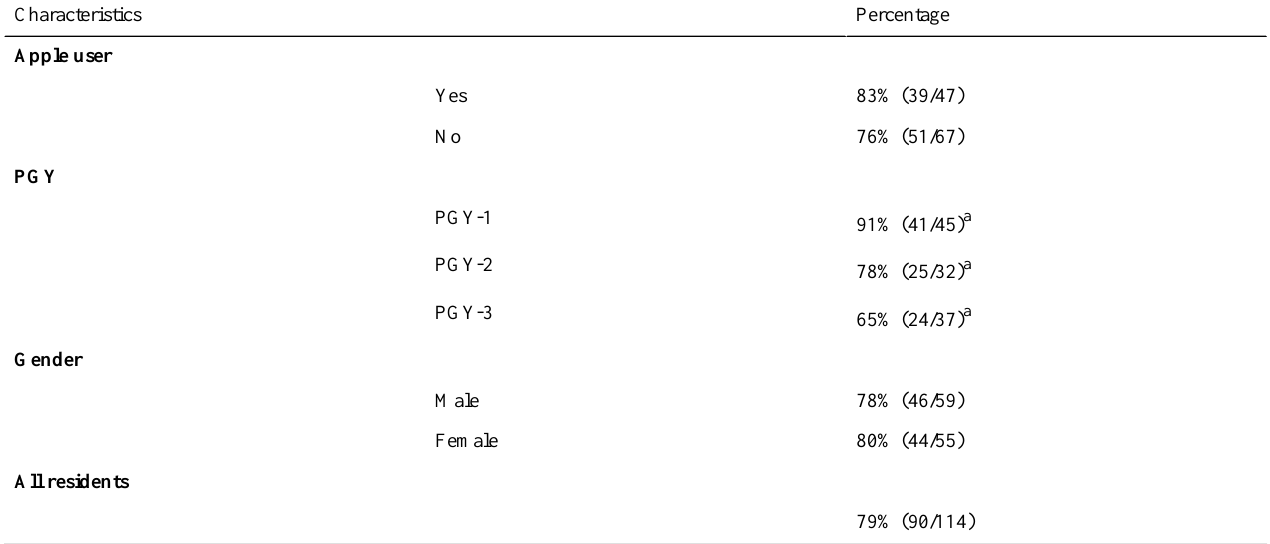
Table 1. Percentage of residents displaying